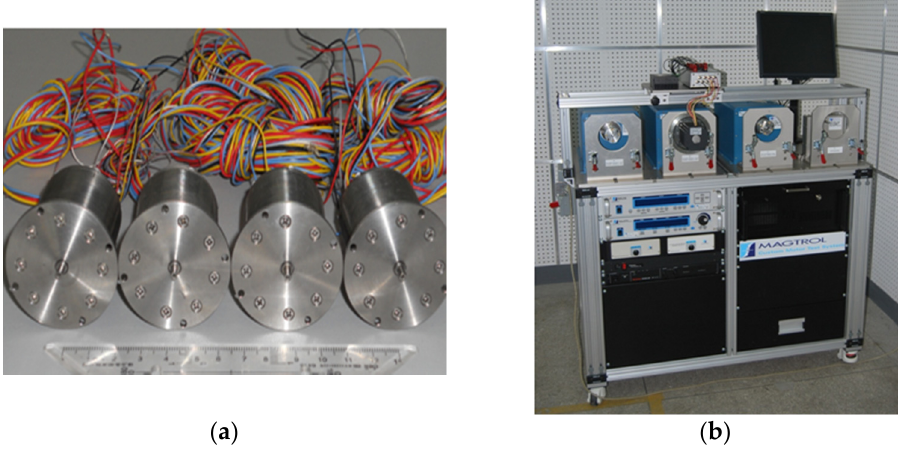
Figure 18. Photos of the experiment: ( a ) prototypes; ( b ) experimental hardware platform.